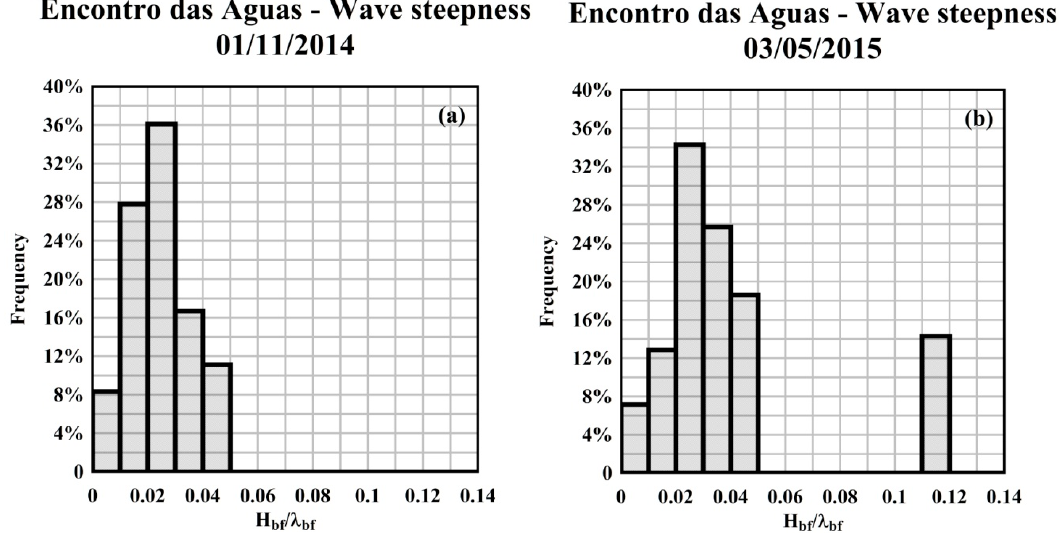
Figure 11. Frequency distribution of bedform steepness H bf / λ bf for (a) FS − CNS1 and (b) FS − CNS2.